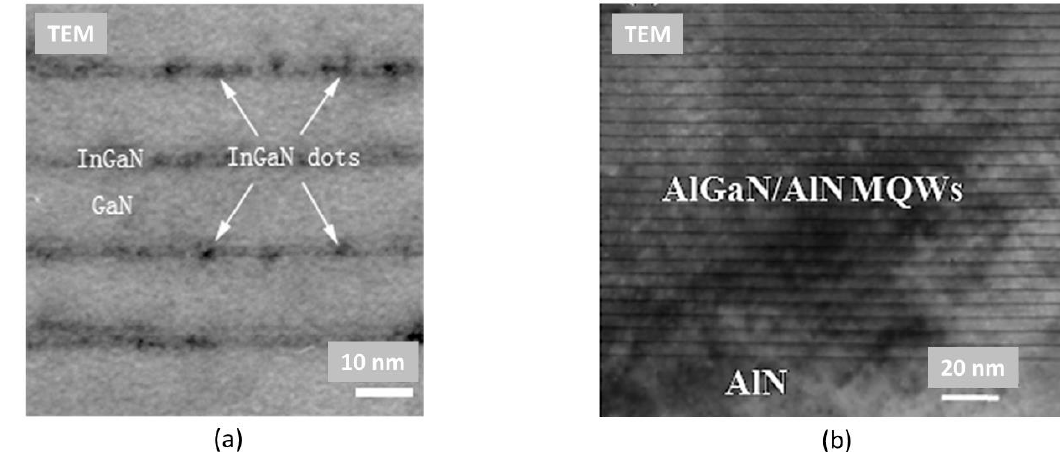
Figure 3. Transmission electron microscopy (TEM) images of: ( a ) InGaN quantum dots [9] formed within a GaN structure and ( b ) AlGaN/AlN quantum wells [10], both within an AlN structure. (Reproduced from [9,10] with the permission of AIP Publishing).